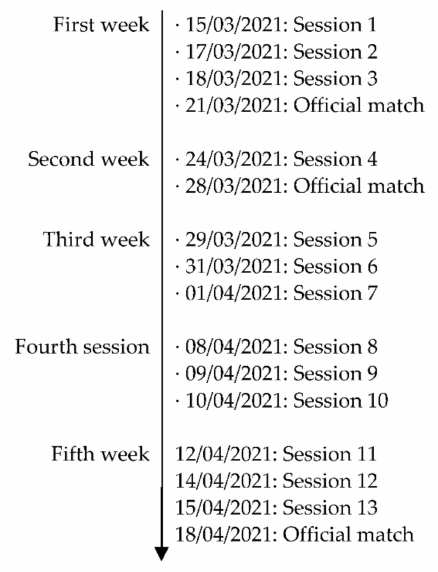
Figure 1. Chronology of the competitive